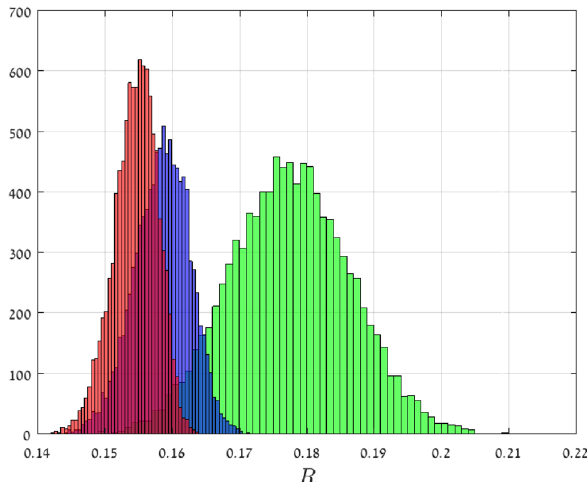
50 (green), n 500 (blue), and n 1500 (red). = = =